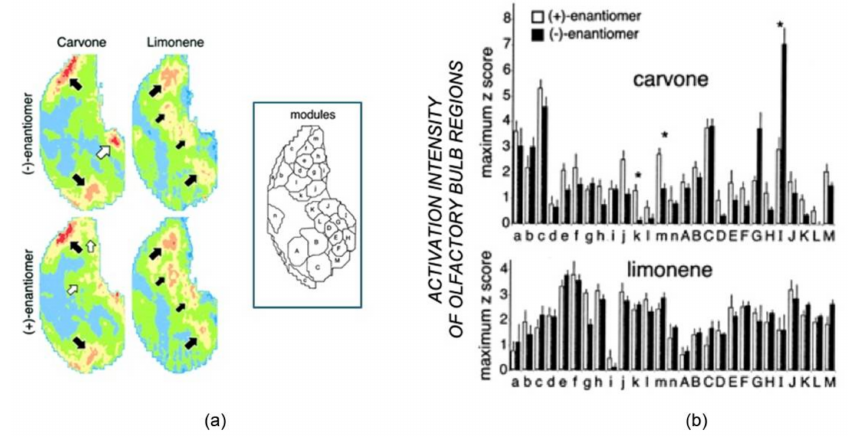
Figure 1. ( a ) Contour charts illustrating the spatial distribution of 2-DG uptake stimulated by carvone and limonene enantiomers. ( b ) Mean maximal z-score response in each of the 27 modules evoked by the enantiomers tested. Adapted from Ref. [19]. Copyright 2001 Society for